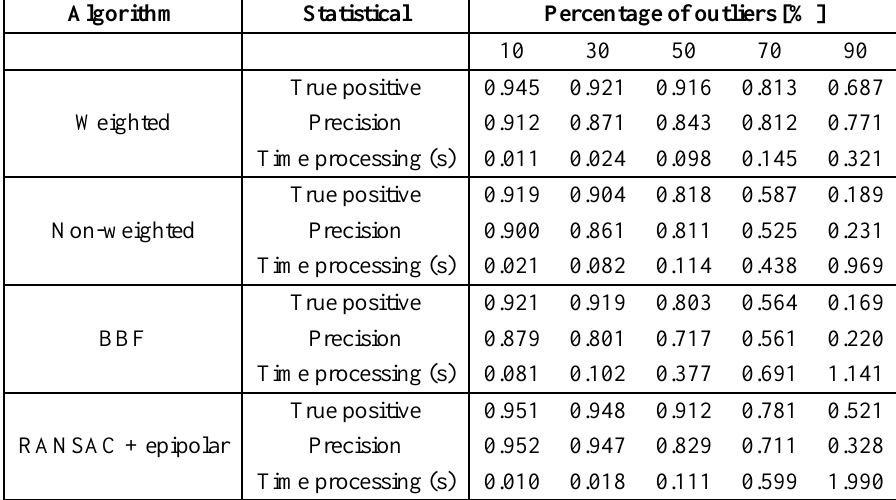
Table 2. Performance of the matching algorithms used in the comparative study for various percentage of outliers.